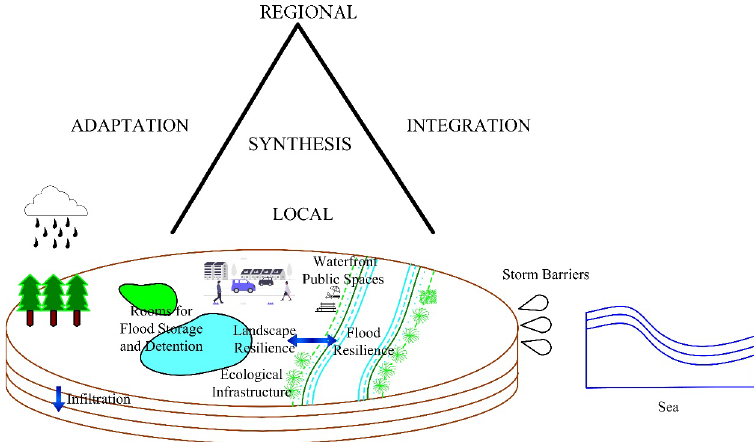
Figure 4. Core diagram of landscape resilience to flooding from